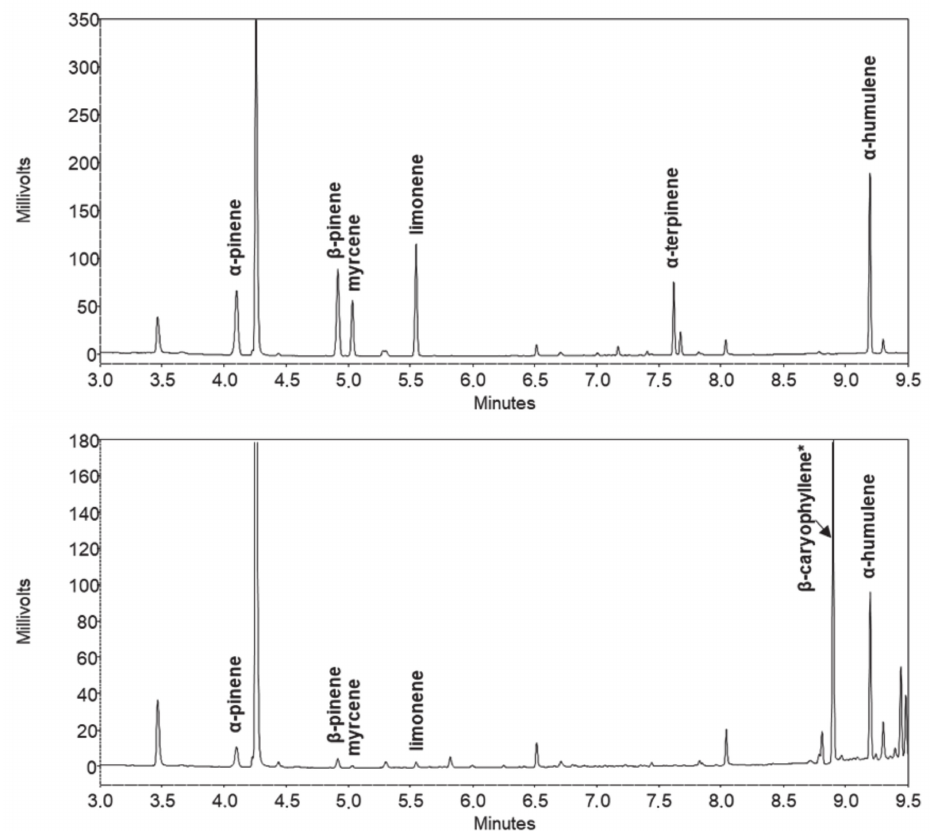
Figure 2. Chromatograms (displayed tR = 3.0–9.5 min) of terpene standard solution ( top ) and hemp plant extract ( bottom ). * β -caryophyllene was identified by mass-spectrometric data.